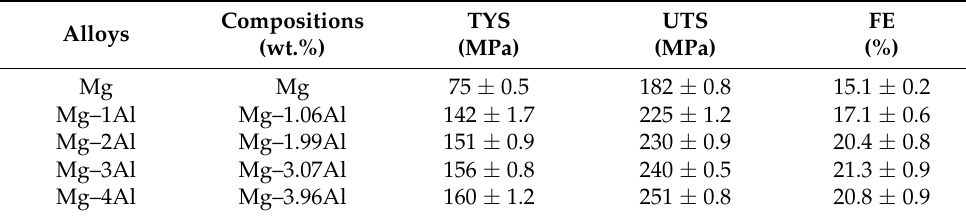
Table 1. Compositions and mechanical properties of the as-extruded Mg–Al alloys. Compositions TYS Alloys (wt.%) (MPa)